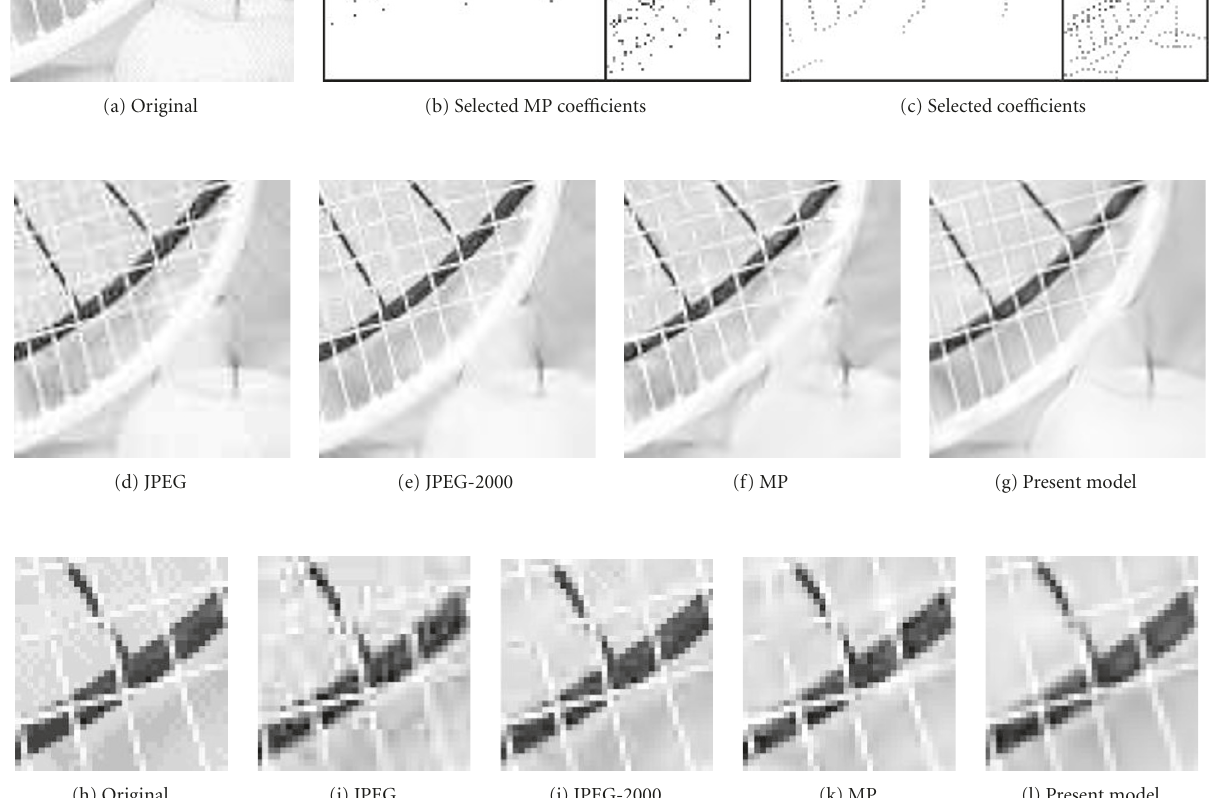
Figure 9: Compression results at 1 . 03 bpp. (a) 96 × 96 tile of the “Bike” image. (b) Coe ffi cients selected by the MP algorithm. (c) Coe ffi cients selected through the sparse approximation steps. (d) Compression with JPEG, PSNR = 25 . 73 dB. (e) Compression with JPEG-2000, PSNR = 29 . 61 dB. (f) Reconstruction by the MP algorithm, PSNR = 25 . 03 dB. (g) Compression by the proposed model, PSNR = 26 . 05 dB. (h), (i), (j), (k), (l) 36 × 36 zoom tile for original, JPEG, JPEG-2000, MP, and the model,